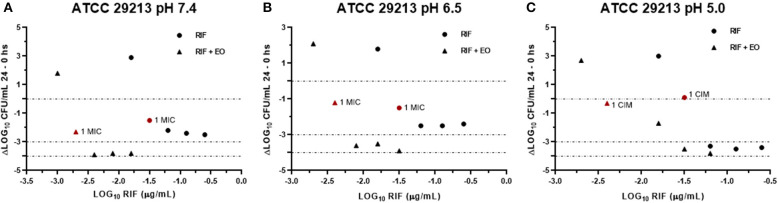
Graphic representation of the antibacterial effect (E: ΔLog CFU/ml 24–0 h) of rifaximin against Staphylococcus aureus ATCC 29213 at pH 7.4 (A), 6.5 (B), and 5.0 (C) in the presence and absence of EO.